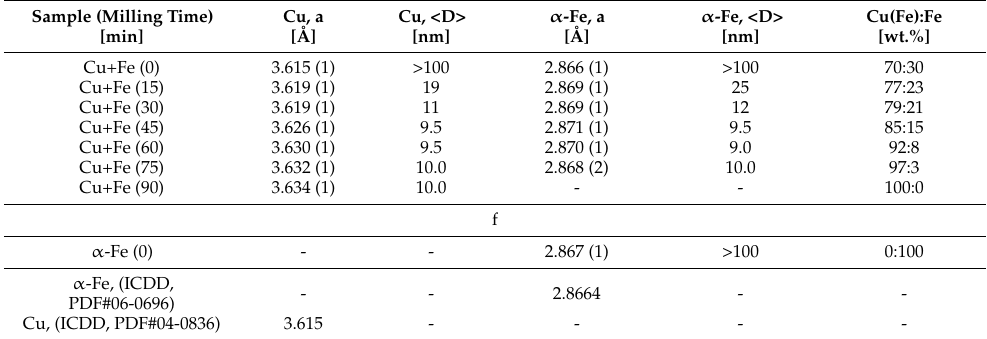
Table 1. Lattice parameters, crystallite sizes <D> and phase ratios Cu(Fe):Fe for the 67Cu–33Fe powders milled for 0–90 min.